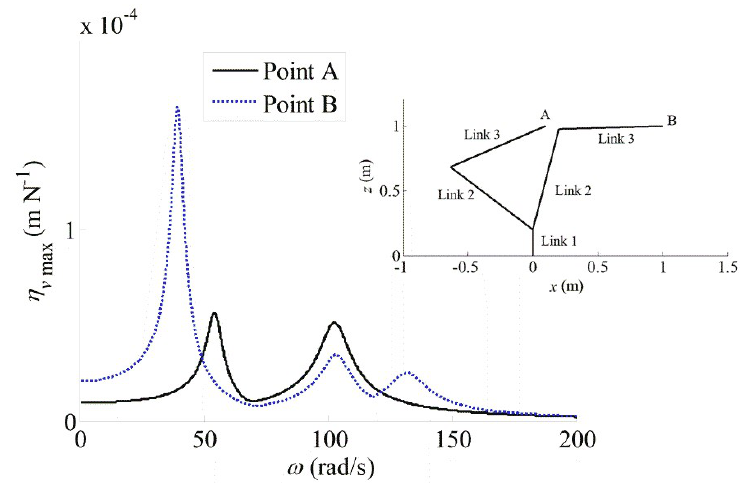
Figure 4. η υmax with different force and torque frequencies at two points. Figure 4. η υ max with di ff erent force and torque frequencies at two